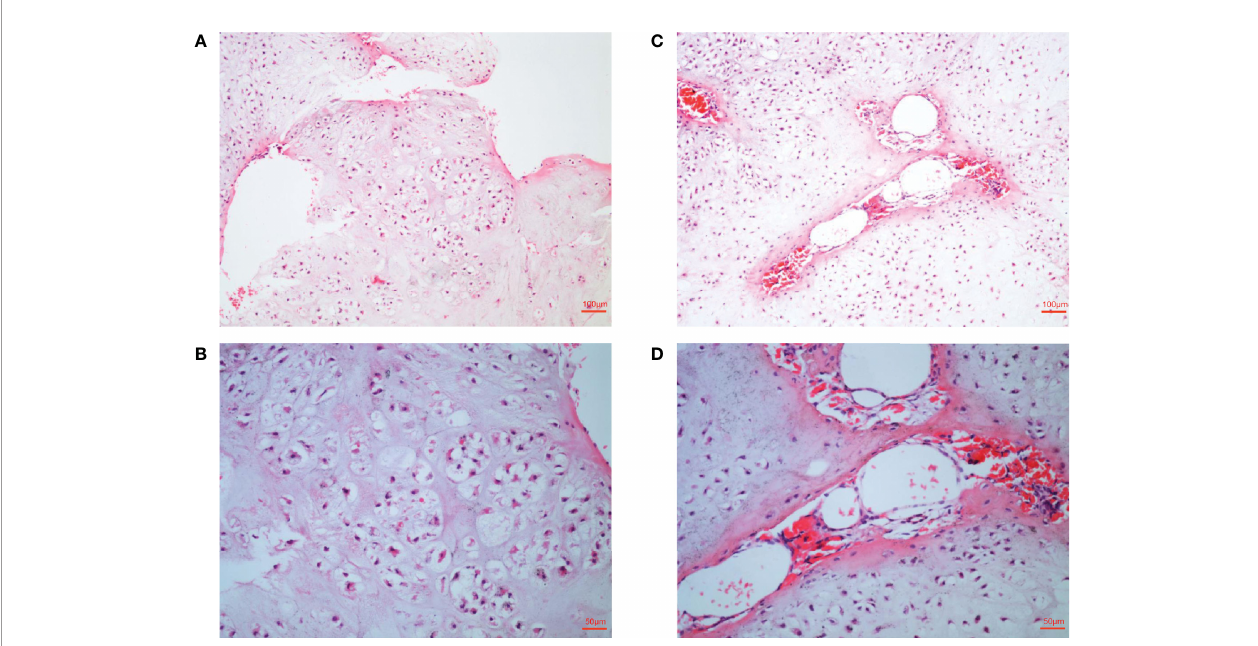
FIGURE 2 | Histological examination of lesions. (A, B) Histological examination manifesting typical enchondroma in the patient ’ s right-hand fi nger bones. The speci fi c manifestation was microscopic appearance of lobular hyaline cartilage with uniform chondrocytes, heaps of chondrocytes, uniform nuclear size and not deep staining (C, D) . Samples were collected from patient ’ s right-hand fi nger bones displaying cavernous hemangioma in the enchondroma tissues. Microscopically, a large number of neoplastic vascular tissues can be seen in the middle of cartilage tissue. The blood vessels are thin-walled and dilated and fi lled with red blood cells.